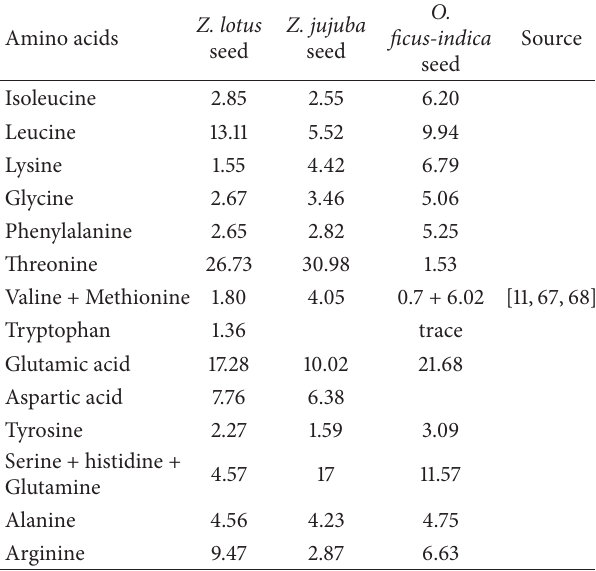
Table 7: Comparison of amino acids content in Z. lotus seeds and other plants. Amino acid contents are expressed as